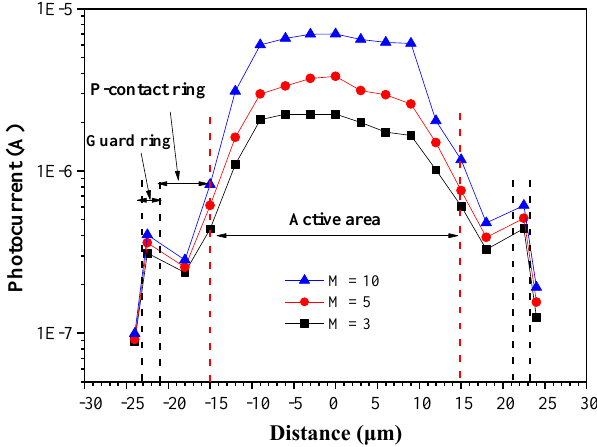
Figure 6. Photocurrent as a function of the distance that across the active area (the diameter) of the proposed SAGCM-APD.